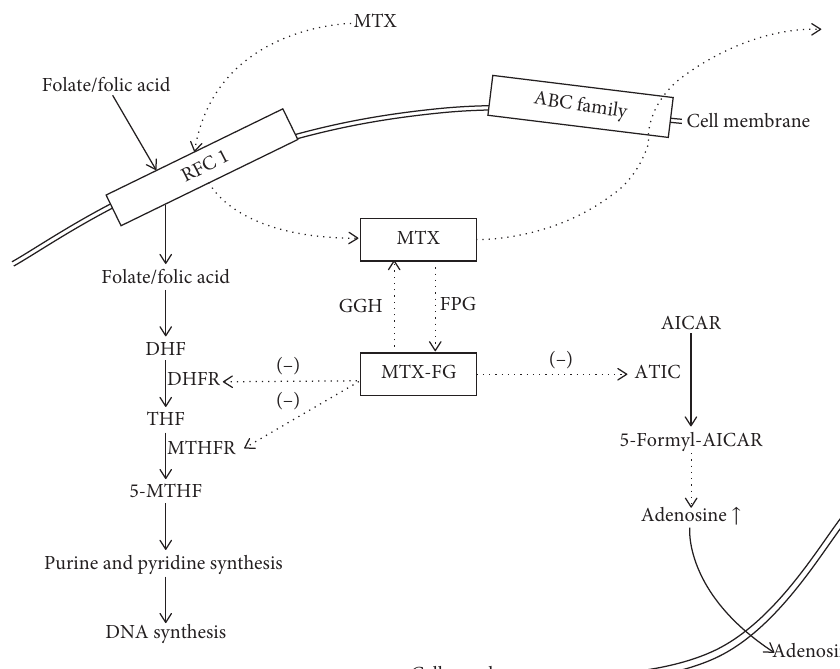
Figure 1: The cellular pathway of folate and MTX. Dietary folate enters the cells through RFC1, as well as MTX. In low-dose MTX treatment, MTX inhibits enzymes of the folate pathway. Ultimately, MTX leads to an increase in intracellular adenosine level, which would cause anti- inflammatory effects. RFC-1 � reduced folate carrier 1; ABC family � adenosine triphosphate-binding cassette (ABC) family; DHF � di- hydrofolate; THF � tetrahydrofolate; GGH � c -glutamyl hydrolase; FPG � folylpolyglutamate synthase; MTX-PG � methotrexate poly- glutamate; DHFR � dihydrofolate reductase; MTHFR � methylene tetrahydrofolate reductase; AICAR � aminoimidazole carboxamide ribonucleotide; ATIC � AICAR